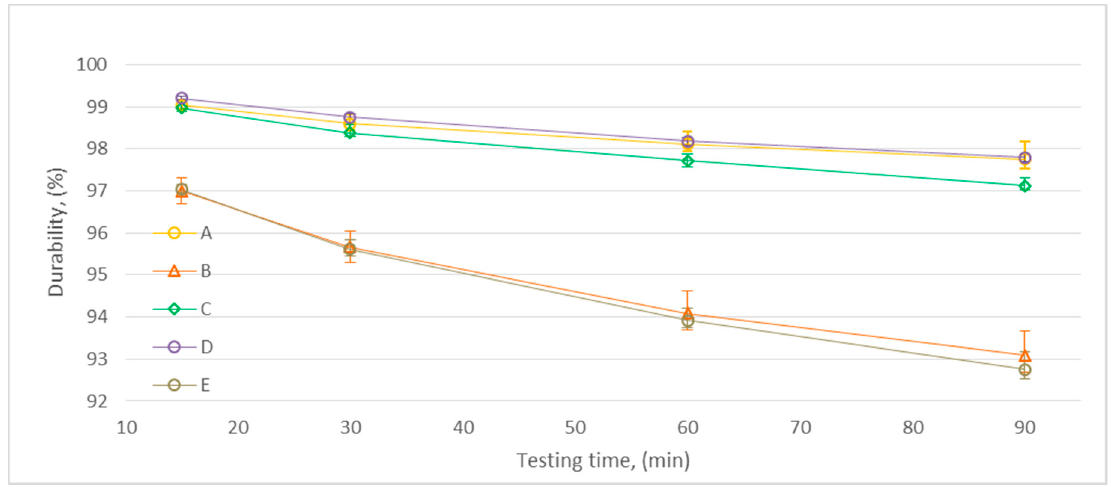
Figure 5. Influence of vibration timing on durability of tested pellets in vertical vibration tests (own study). Table 2. ANOVA test results for the mass of crumbs due to vertical